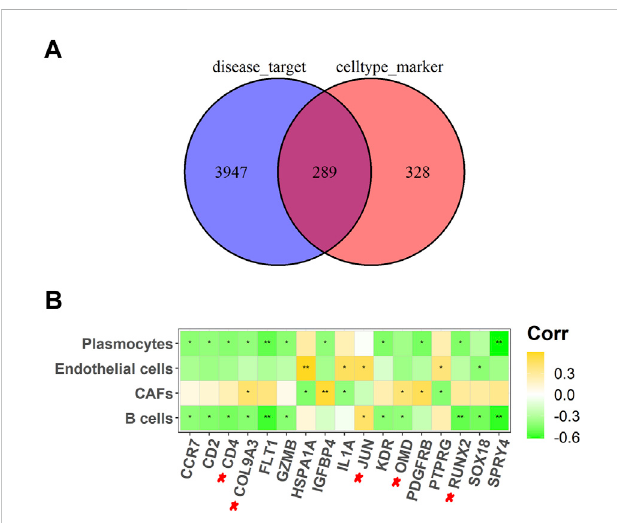
FIGURE 3 Screening out key targets for OS. (A) A Venn diagram of OS- related targets and four different cell types marker genes; (B) Heat map of 17 potential targets correlated with cell abundance in B cells, CAFs, endothelial cells, and plasmocytes. * p < .05, ** p <